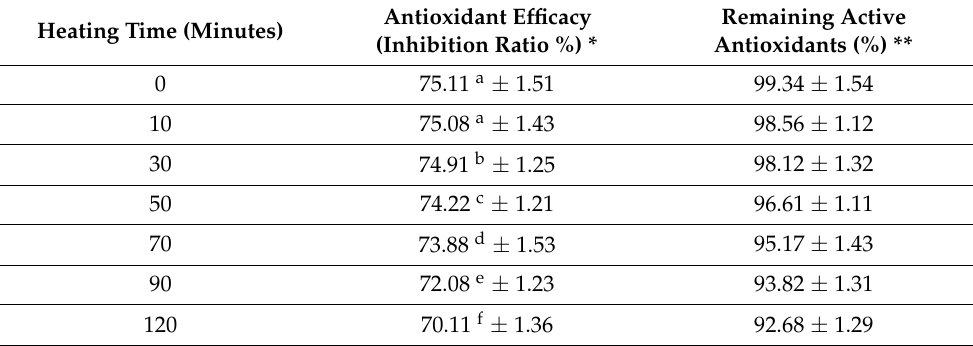
* The different letters indicate significant differences at the probability level p < 0.05. ** Remaining active antioxidants = the percentage of inhibition (sample after the heat treatment at 185 ◦ C) × 100/the percentage of inhibition (sample before the heat treatment at 185 ◦ C)